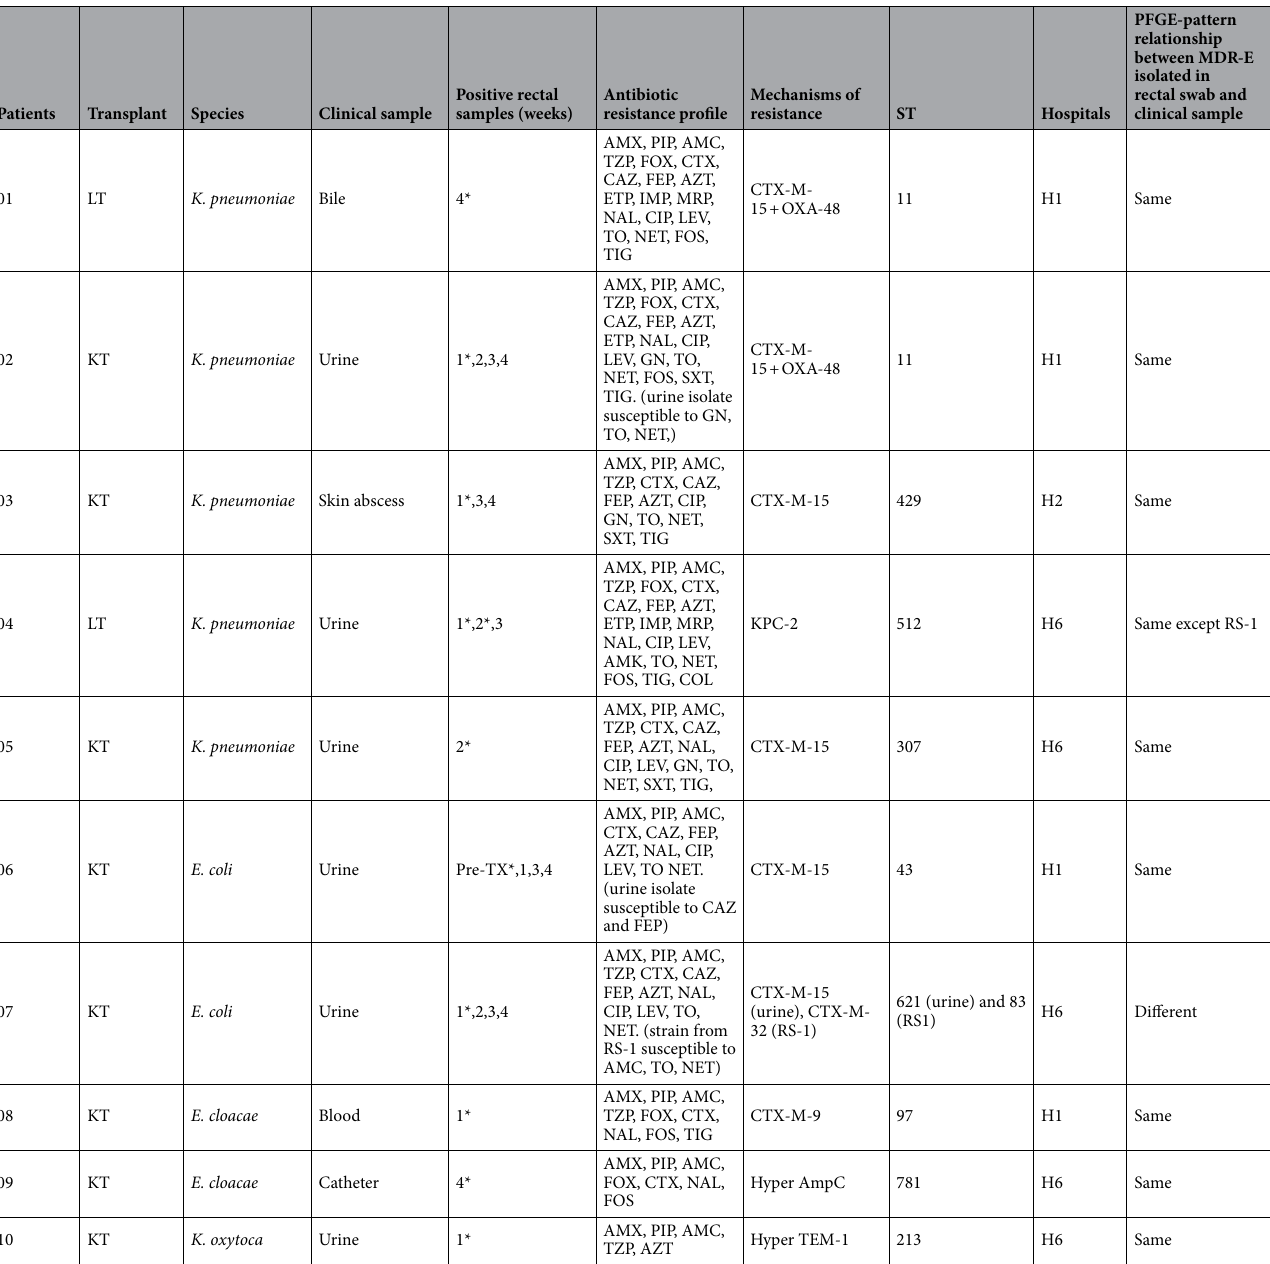
Table 5. Characteristics of the MDR-E isolated by rectal swab and clinical samples from eight kidney and two liver transplant recipients. KT kidney transplant, LT liver transplant, ST sequence type, AMC